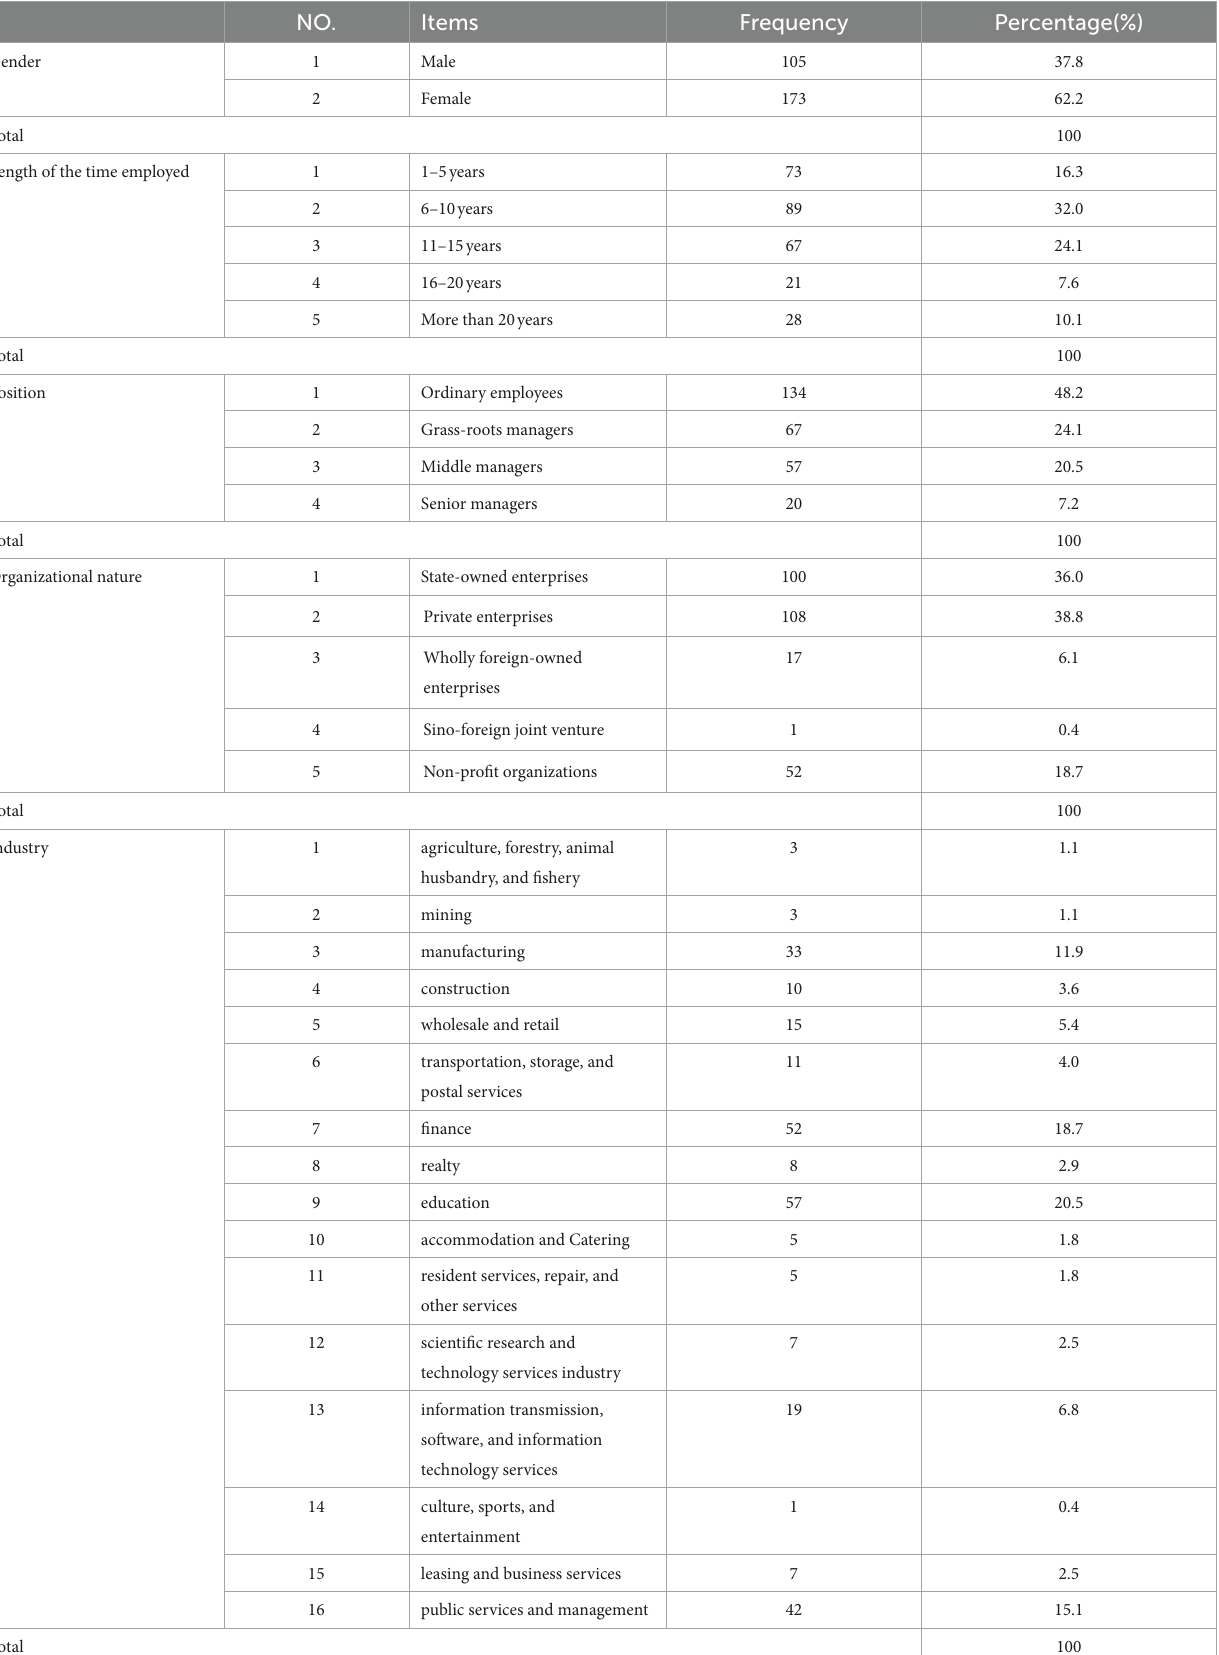
TABLE 2 Description of the questionnaire sample